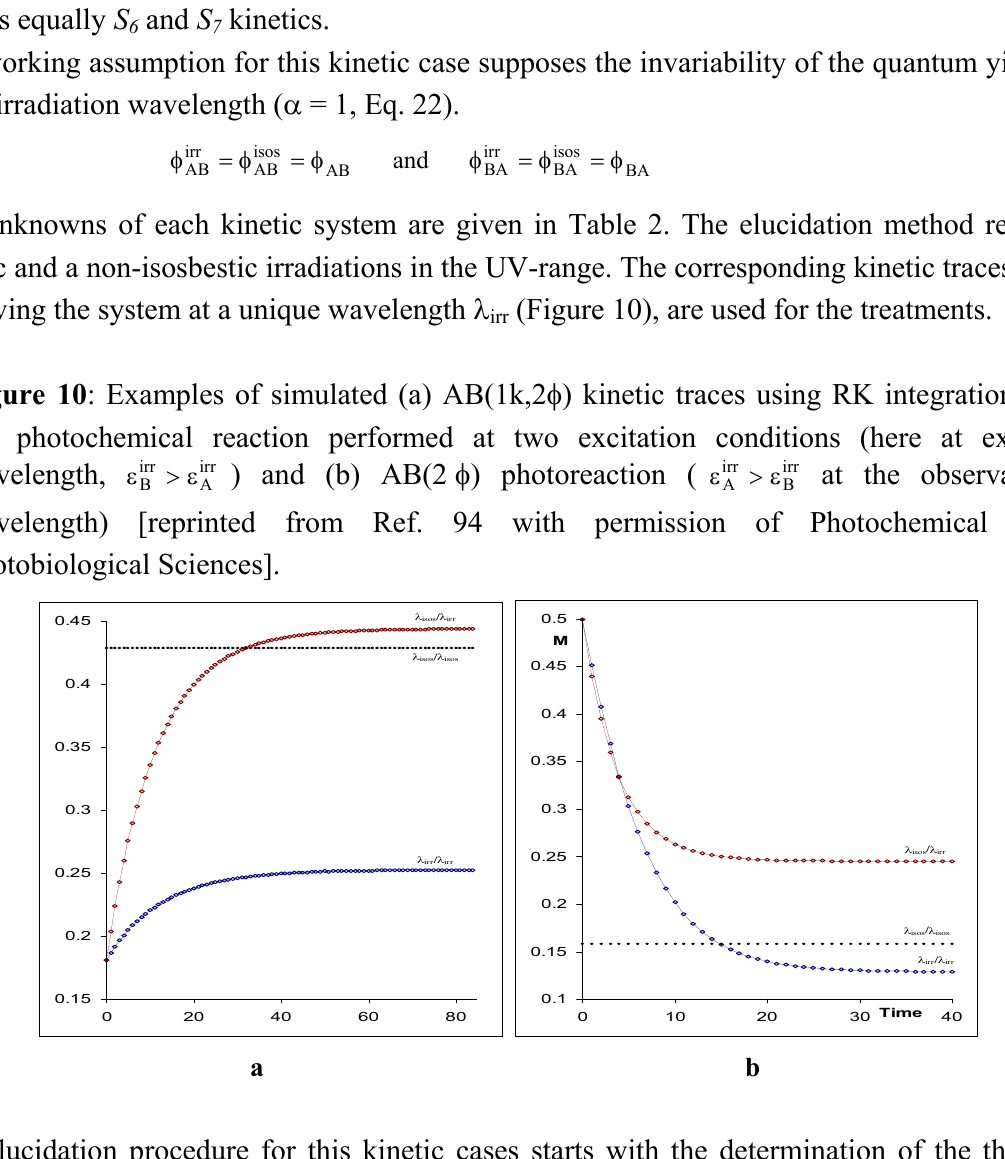
ε>ε at the observation A